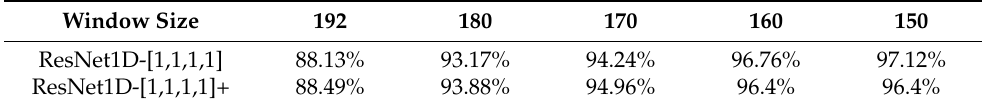
Table 3. The effect of different window size on the accuracy of the